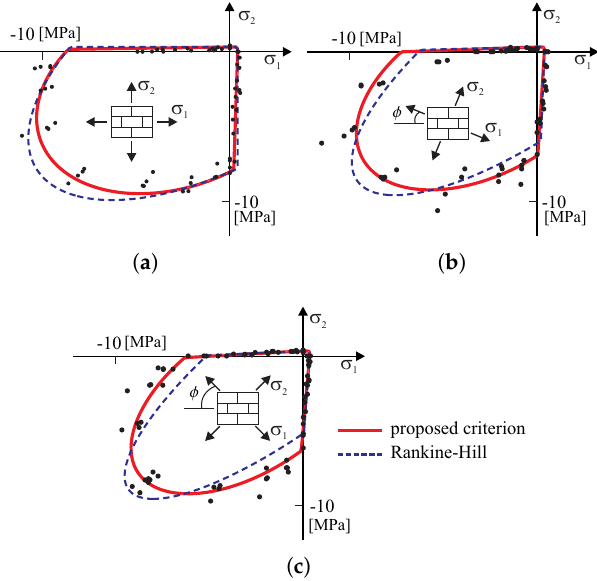
Figure 4. Comparison of the proposed criterion with the experimental results of Page [7,8] depending on the inclination axes of orthotropy relative to the principal axis: ( a ) φ = 0.0, ( b ) φ = 22.5, ( c ) φ =